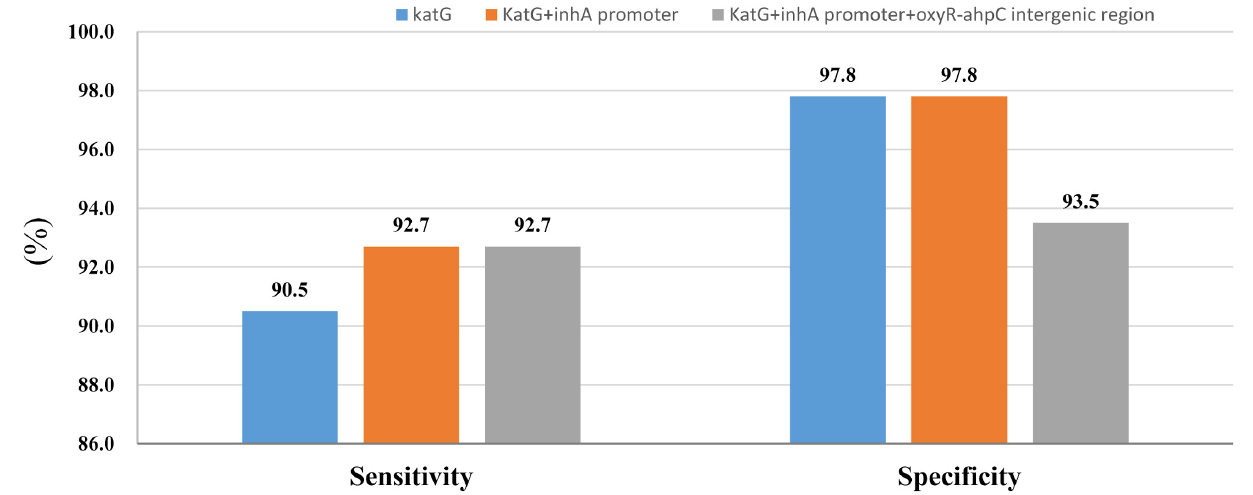
katG 315 can make a preferable set for INH-resistance diagnoses, and the mutation sites in katG except 315 were scattered, which made these codons have less diagnostic value when used in gene chip, line/dot-blot hybridization or multiplex fluorescence melting curve